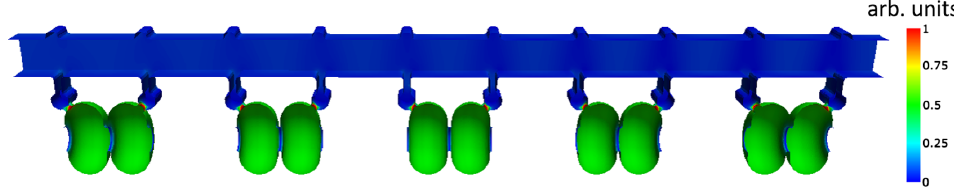
FIG. 15. The surface magnetic contour of one manifold for a 20-cell parallel feed